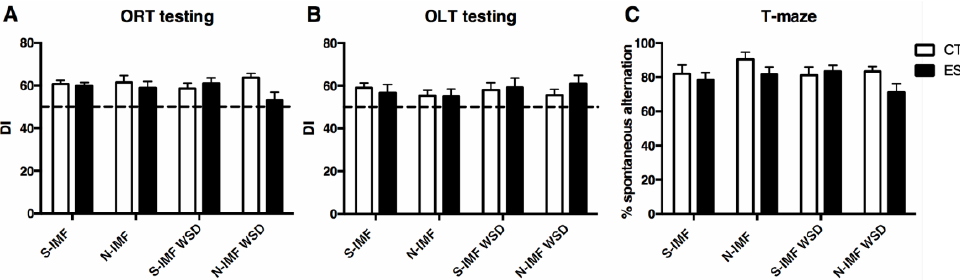
Figure 4. No cognitive impairment is observed in adulthood. ES, N-IMF, or WSD did not affect cognitive performance in the object recognition task (ORT) ( A ), object location task (OLT) ( B ), or T- maze ( C ). Statistical analyses were performed using three-way ANOVA.